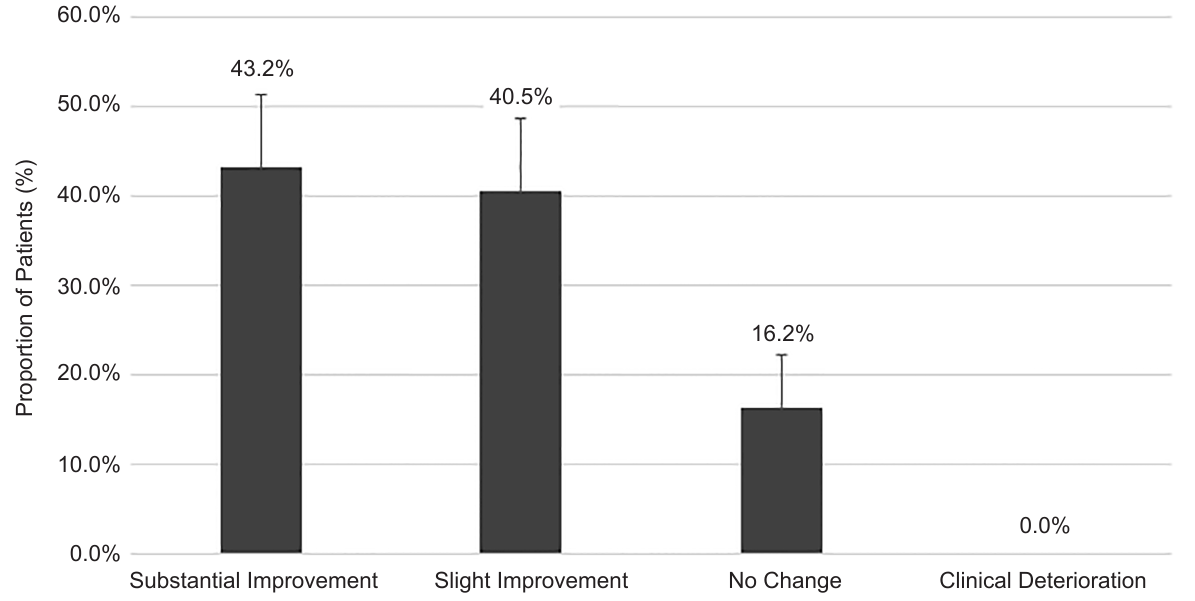
Figure 3. Subjective clinical change after repeat midazolam administration for behavioral emergencies as reported by